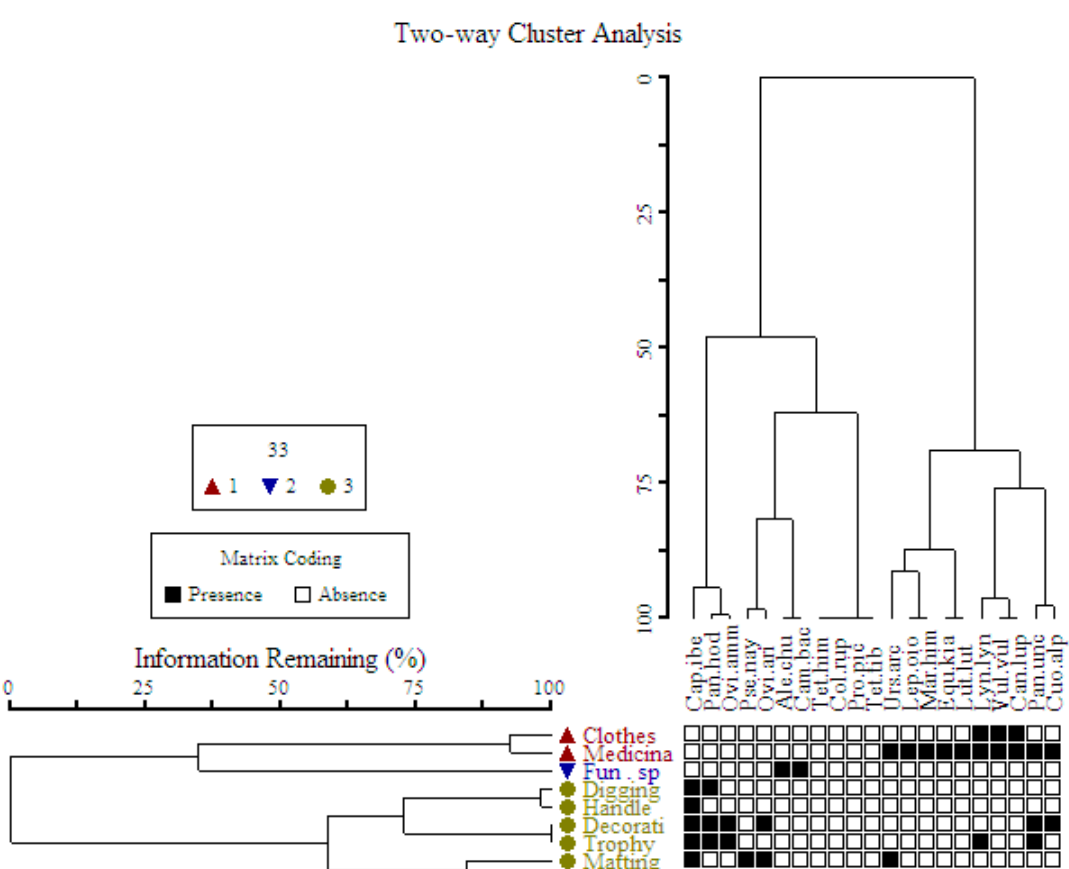
Figure 6. Two Way Cluster Analysis based on Sørenson’s similarity index of animal species.